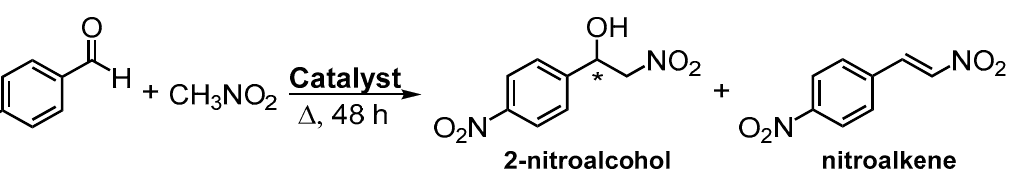
Table 6. Influence of catalyst type on the Henry reaction between 4-nitrobenzaldehyde and nitromethane.